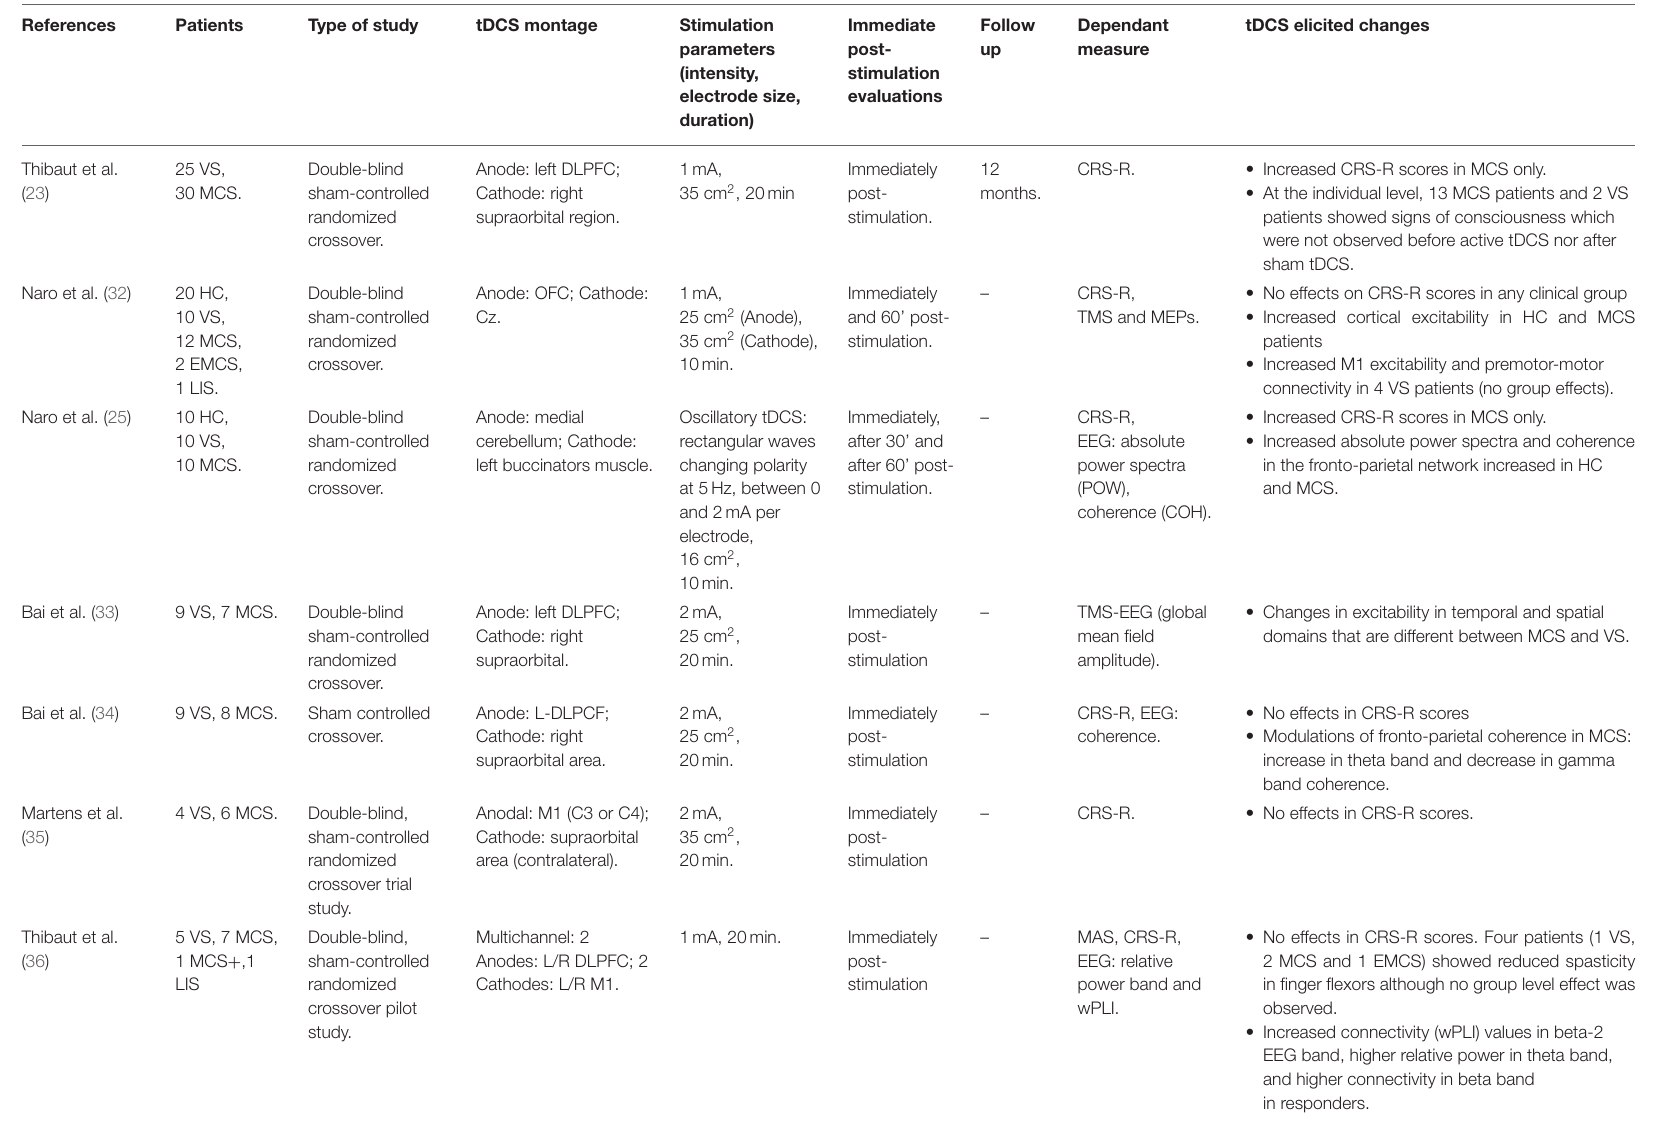
TABLE 1 | Overview of single session tDCS studies in